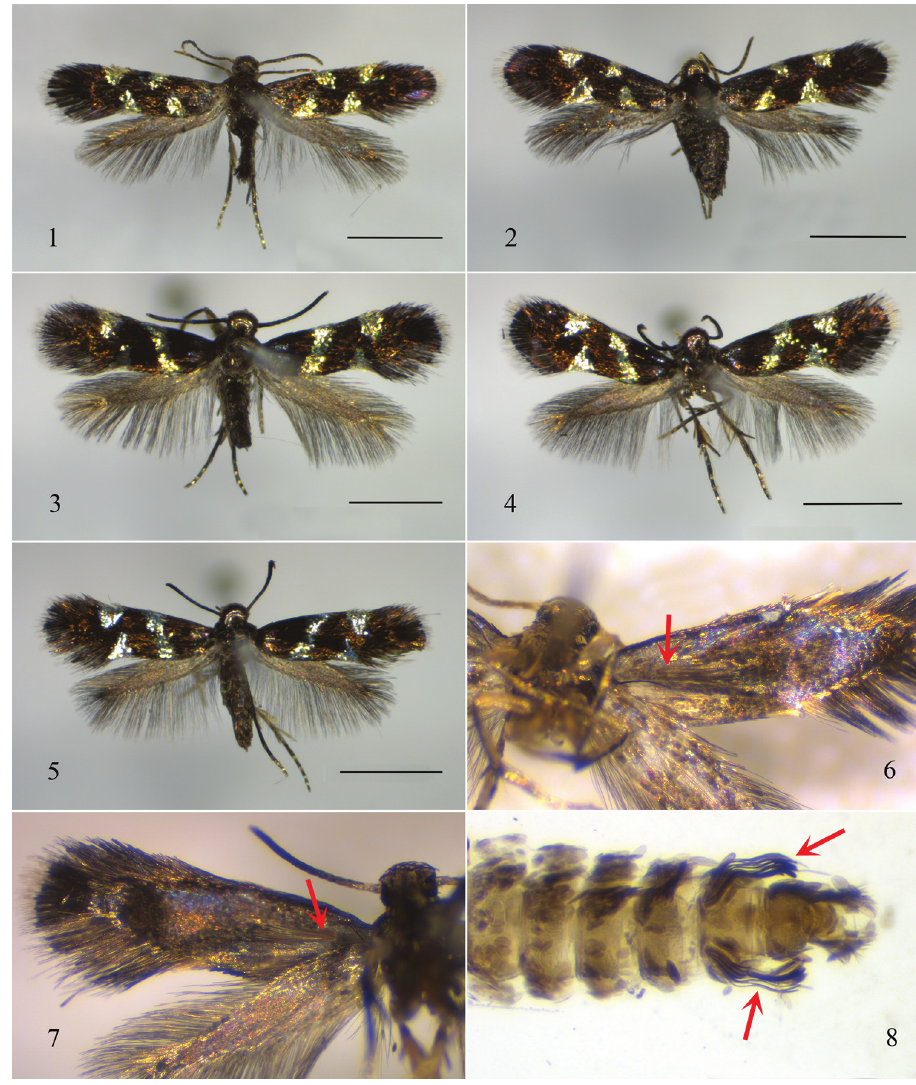
Figures 1–8. Adult of Antispila species. 1 A. kunyuensis , holotype, male, SDNU.QD170705.1 2 A. ku- nyuensis sp. n., paratype, female, SDNU.YT170601.4 3 A. uenoi , male, SDNU.QD170705.1 4 A. uenoi , female, SDNU.QD170705.3 5 A. uenoi , female, SDNU.QD170707 6 A. kunyuensis , male, paratype, ventral view of forewing indicating bristles of retinaculum, SDNU.YT170601.3 7 A. uenoi , ventral view of forewing indicating bristles of retinaculum 8 A. uenoi , male, indicating paired tufts of slender scales on the 7 th abdominal segment, photographed during dissection in water, SDNU.QD170705.1. Scale bars: 1.0